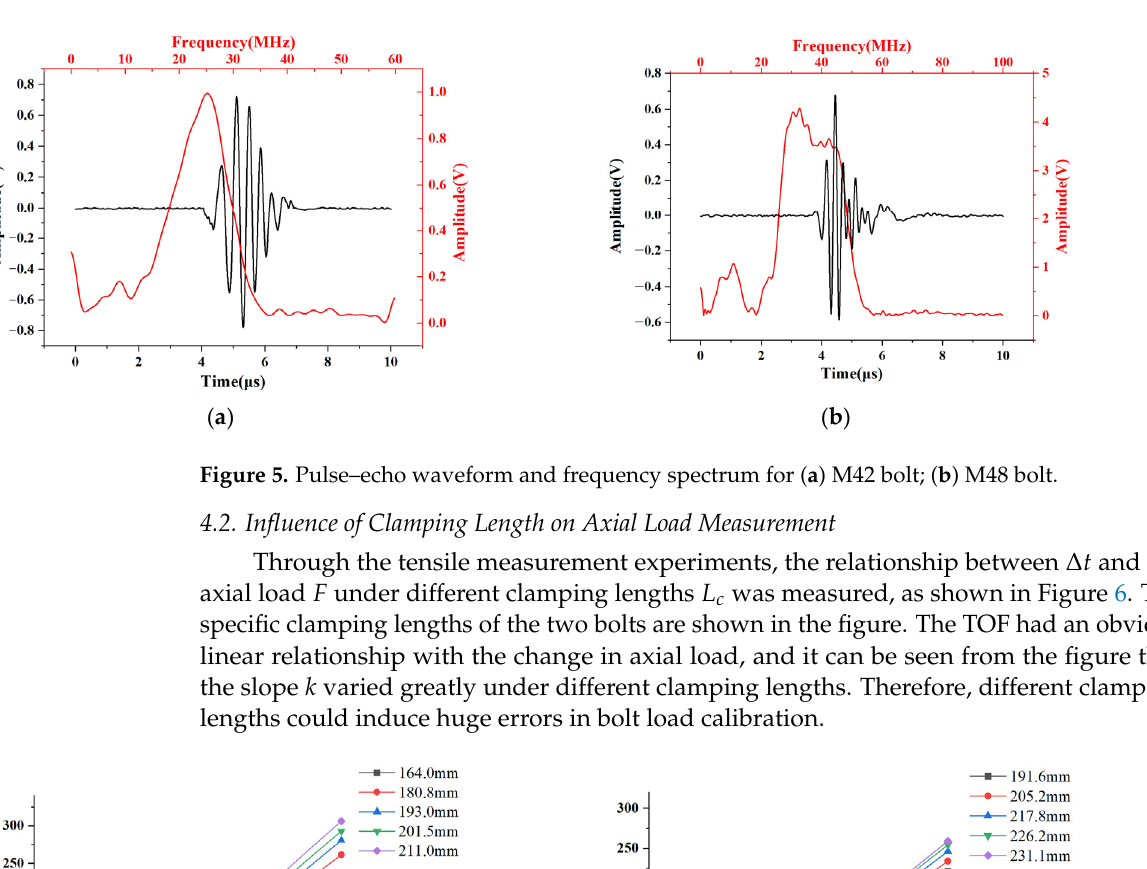
Figure 5. Pulse–echo waveform and frequency spectrum for ( a ) M42 bolt; ( b ) M48 bolt.